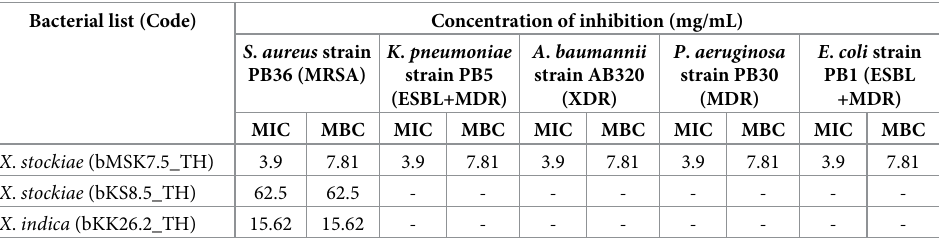
Table 4. Antibacterial activity of Xenorhabdus extracts against antibiotic-resistant bacteria as assessed by mini- mum inhibitory concentration and minimal bactericidal concentration. Bacterial list